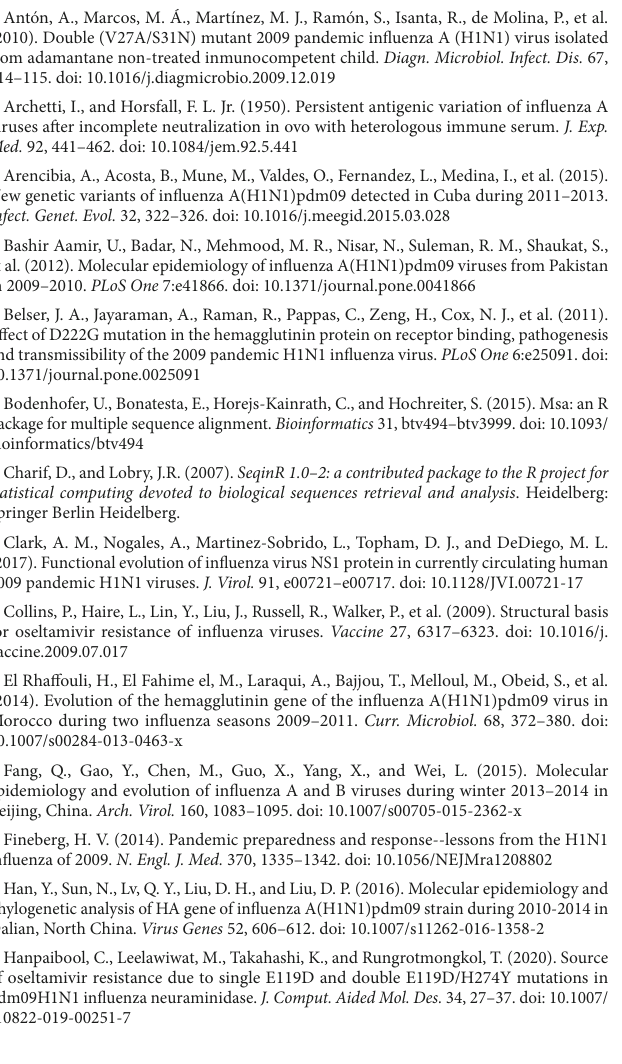
SUPPLEMENTARY FIGURE S1 Figure 1 Viral titers in tissues of dead guinea pigs in the 752/2017 treatment group At 4 DPI, viral titers in turbinate, trachea, and lung of dead guinea pigs in the 752/2017 treatment